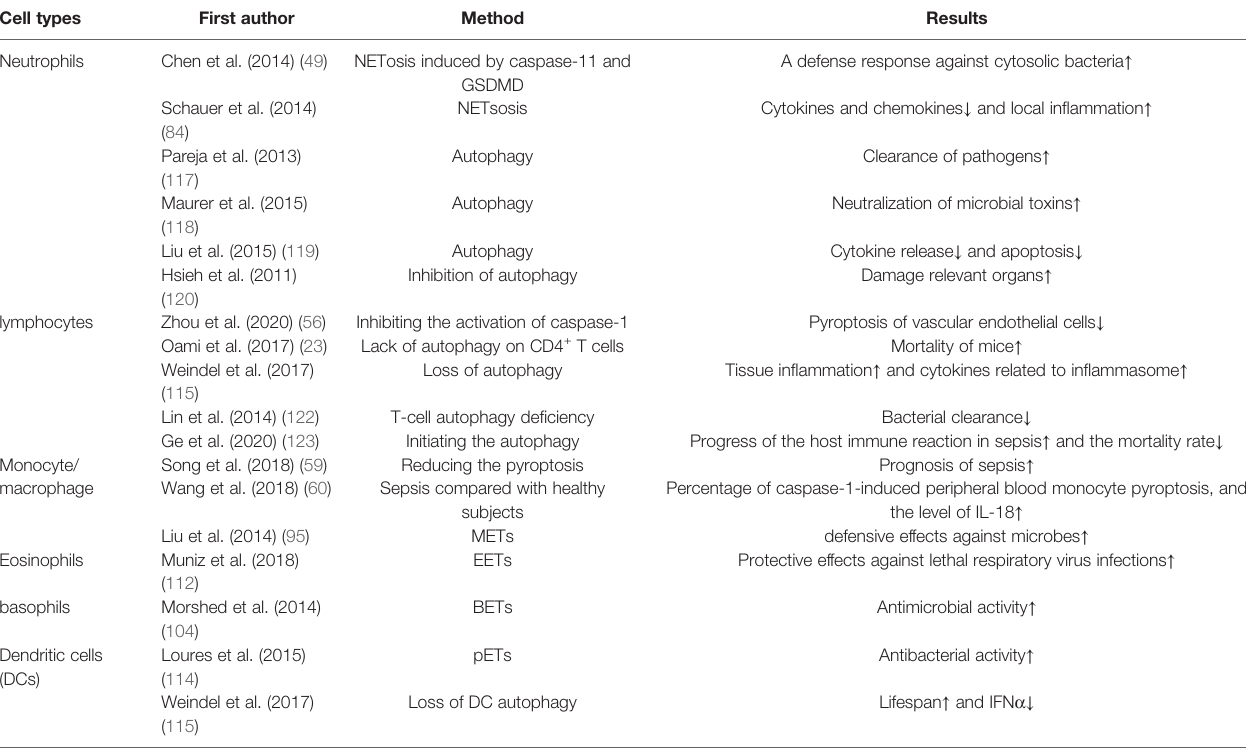
TABLE 2 | The pros of various self-sacri fi ce of immune